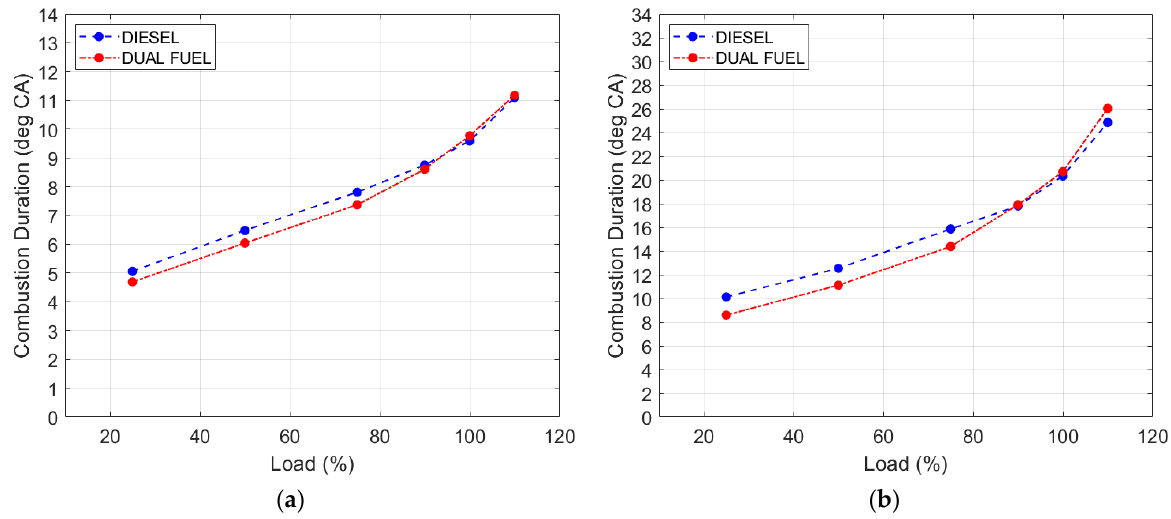
Figure 10. ( a ) Combustion duration for 50% fuel mass fraction burnt, diesel and DF modes; ( b ) Com- bustion duration for 90% fuel mass fraction burnt, diesel and DF modes.